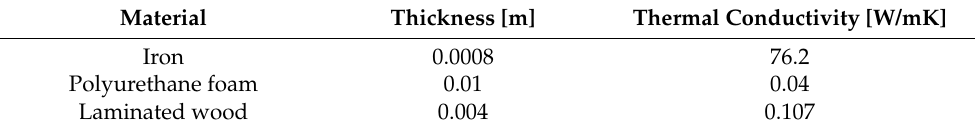
Table 3. Thickness and thermal conductivities for the materials of the wall of the bus. Material Thickness [m] Thermal Conductivity [W/mK] Iron 0.0008 76.2 Polyurethane foam 0.01 0.04 Laminated wood 0.004 0.107